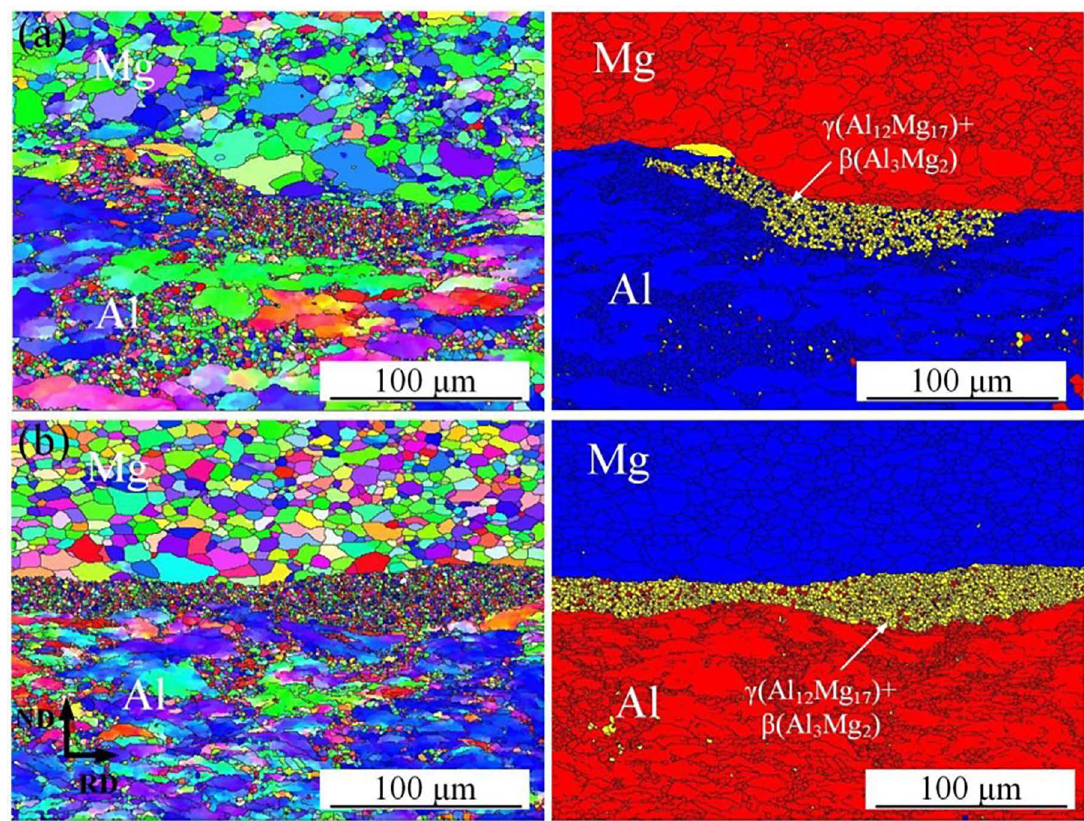
Figure 2. Inverse pole figure (IPF) maps and phase maps of SEM/EBSD images obtained from Mg/Al composite plates (a) as-rolled, (b) annealed at 250 ºC for